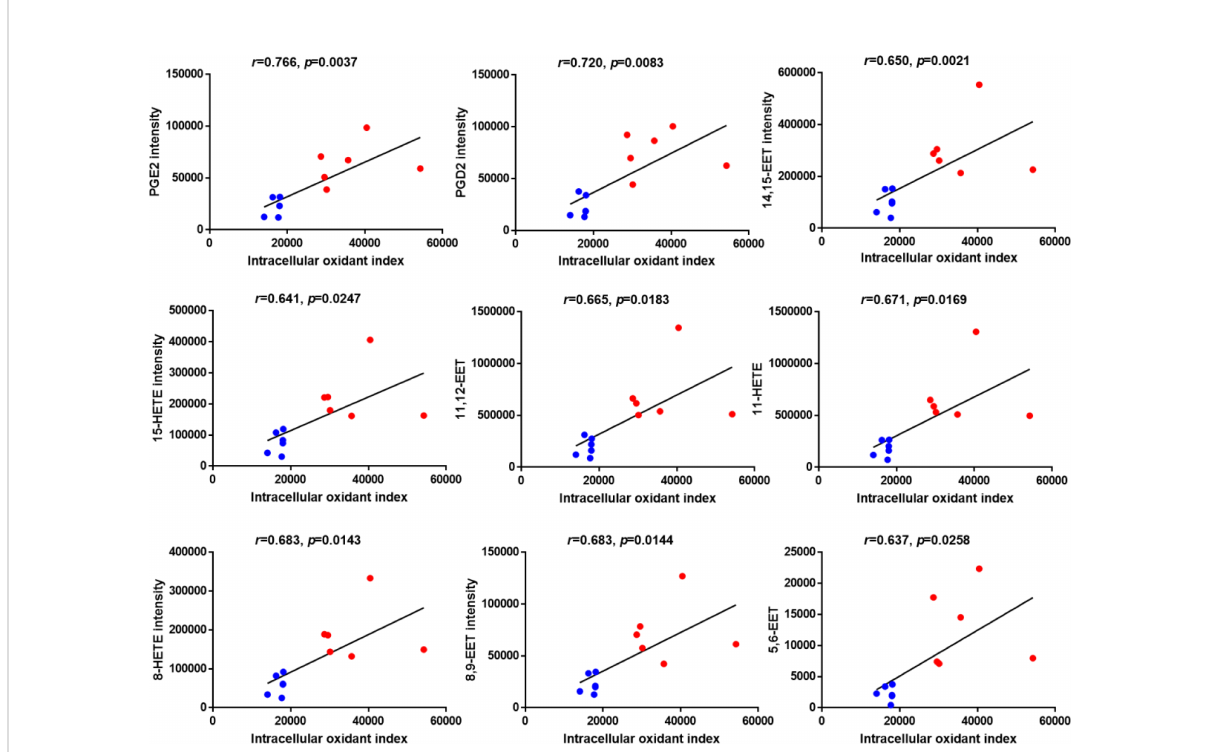
FIGURE 4 Correlation analysis between the levels of signi fi cantly changed oxidized fatty acids and the intracellular oxidant index of HAECs treated with HDLs determined by Pearson ’ s analysis. Blue dots indicate HDL from healthy control group and red dots indicate HDL from diabetic group. N=6 for each